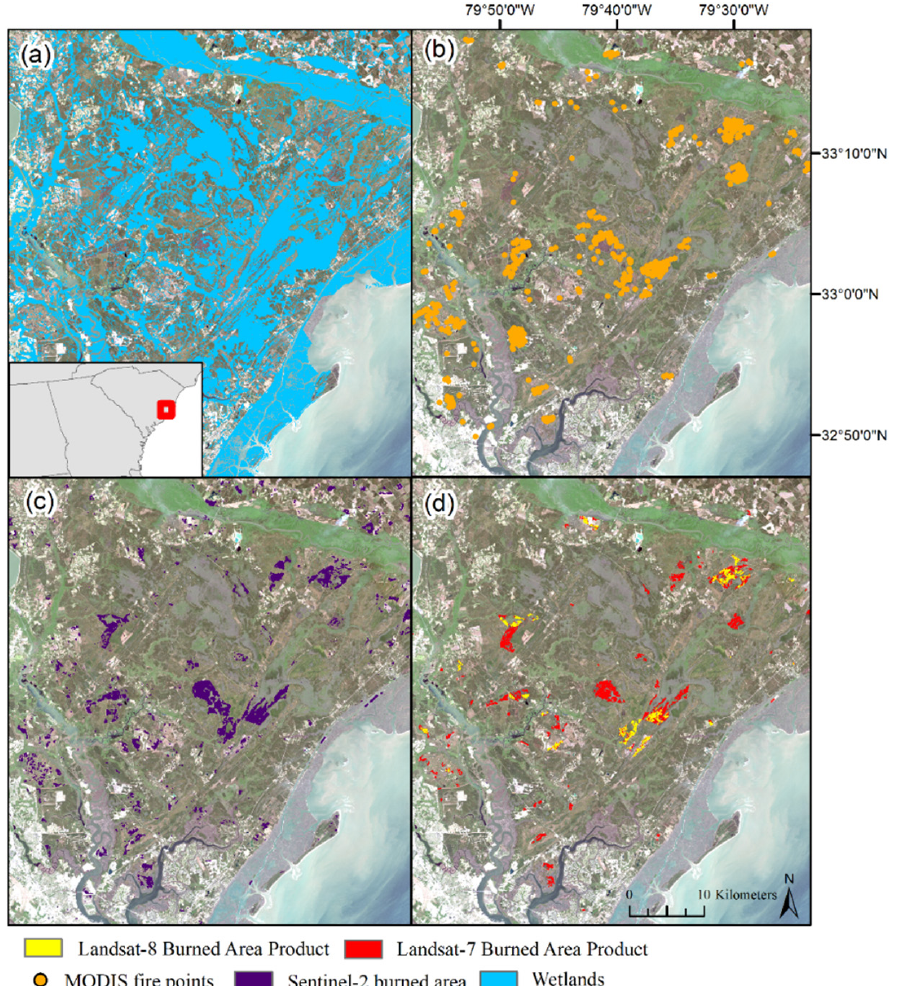
Figure 8. Burned area mapped across South Carolina wetlands, including ( a ) a background image from Landsat-8 collected on 28 March 2019; ( b ) active fire Moderate Resolution Imaging Spectrora- diometer (MODIS) points; ( c ) Sentinel-2 burned area; and ( d ) layered from top to bottom, burned area product from Landsat-8, Landsat-7, and Sentinel-2.